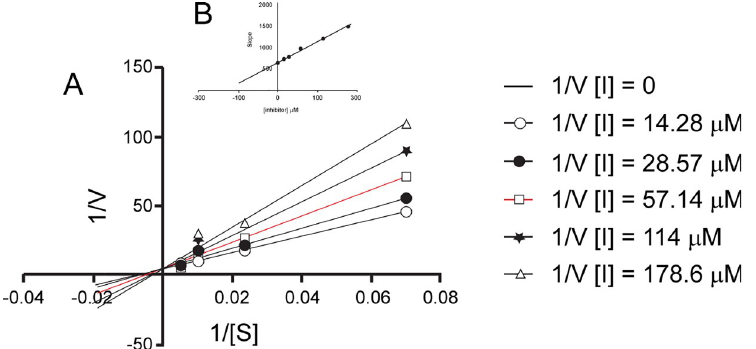
Fig 9. Determination of binding affinity and mode of inhibition of compound 9a. (A) Lineweaver–Burk plot (A) and Dixon slope plot (B) .